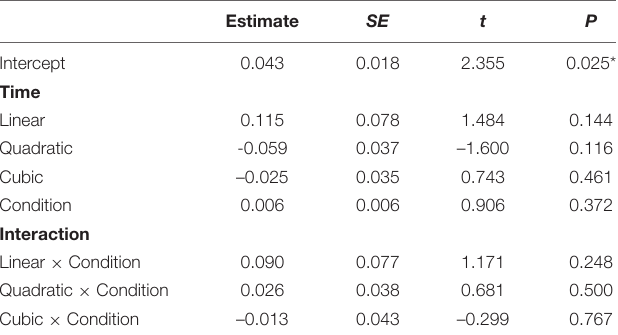
TABLE 4 | Results of growth curve analysis on Mandarin listeners’ proportions of fixations to SR-T3 targets and SR-T3 competitors. Estimate